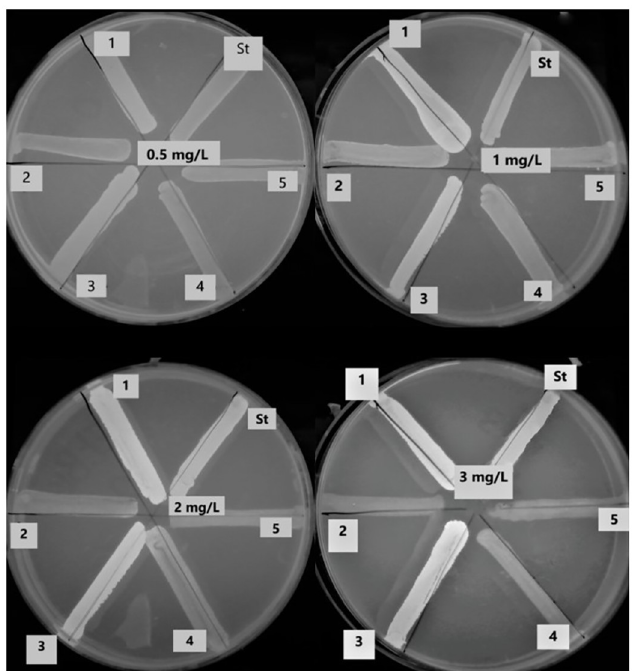
Fig 3. Representative example of different efflux capacities of 5 tested isolates and 1 standard isolate ( S . aureus ATCC 25923) at different EtBr concentrations (from 0.5 to 3 mg/L) under UV transilluminator showing positive fluorescence (negative efflux; Isolates 1, 3 and St), negative fluorescence (positive efflux; Isolates 2, 4 and 5).